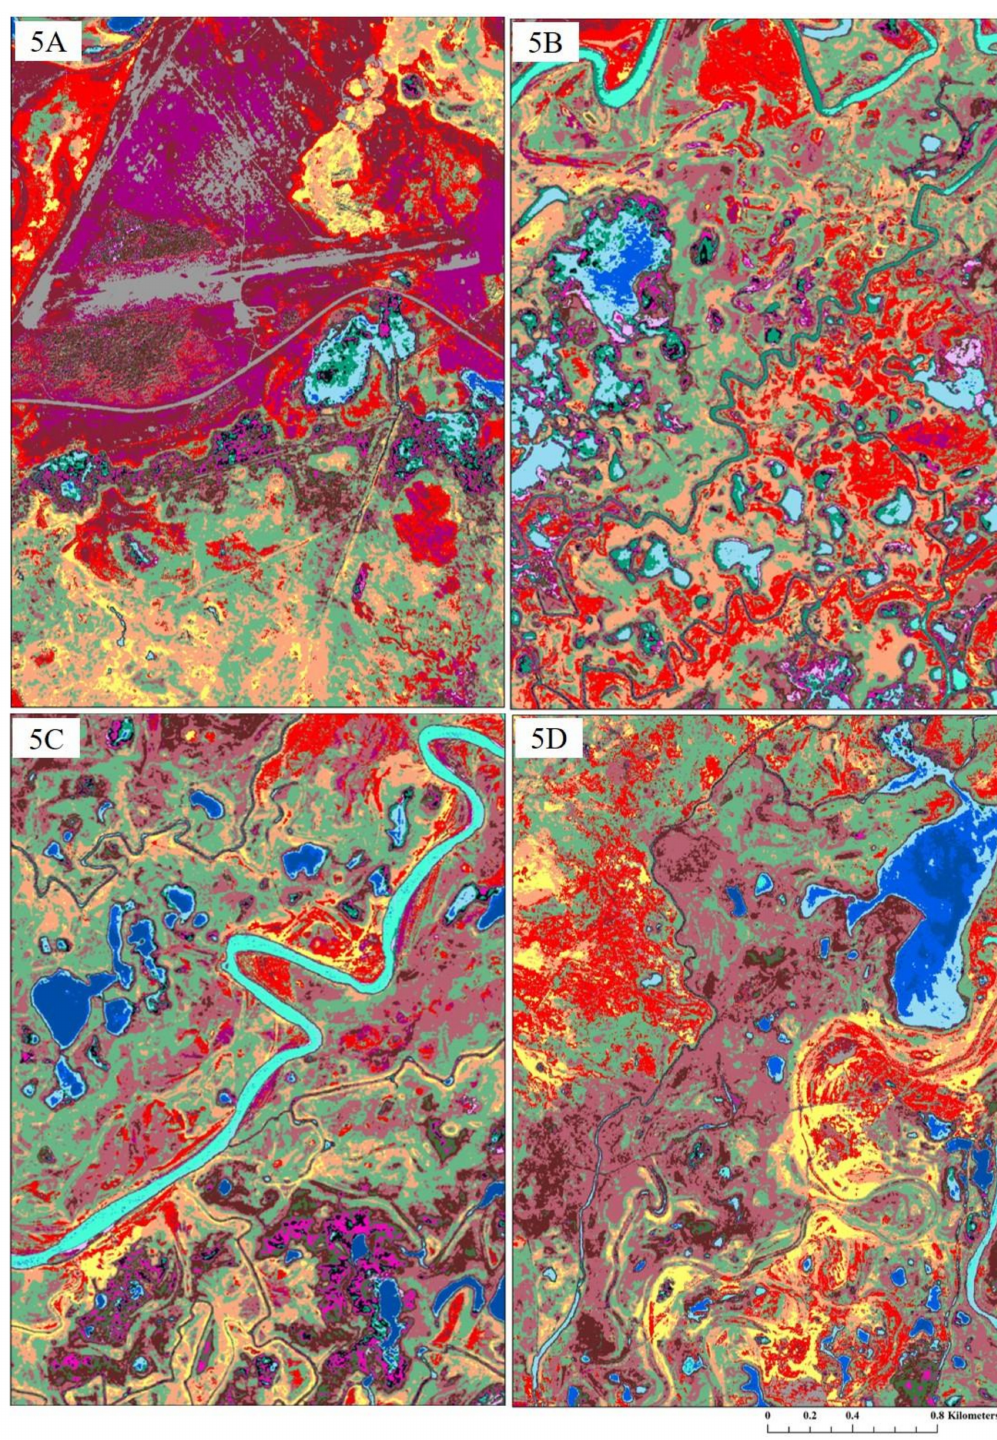
Figure 5. ( a ) Genus-level wetland and aquatic habitats classification map (pixel-based RF approach using three-layer stack). Four focal areas (5 A –5 D ) are shown in finer detail in ( b ). Percent values given in parentheses represent the approximate abundance of each genus or habitat found in the field-based analyses for each class. ( b ) Finer-detailed genus-level wetland and aquatic habitat classification thematic maps developed using the pixel-based RF approach for the areas of interest shown by white-colored squares in ( a ). Classes correspond to the legend in ( a